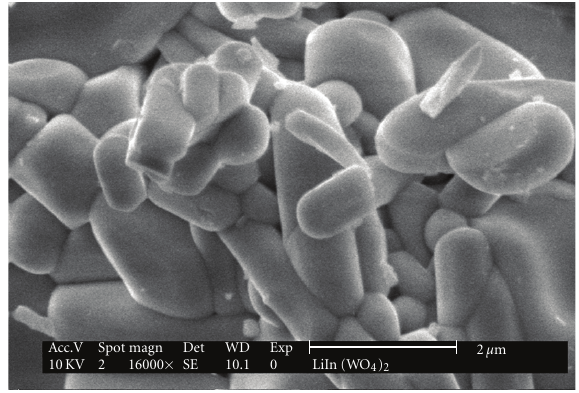
Figure 3: SEM micrograph of LiIn 1 − x Tm x (WO 4 ) 2